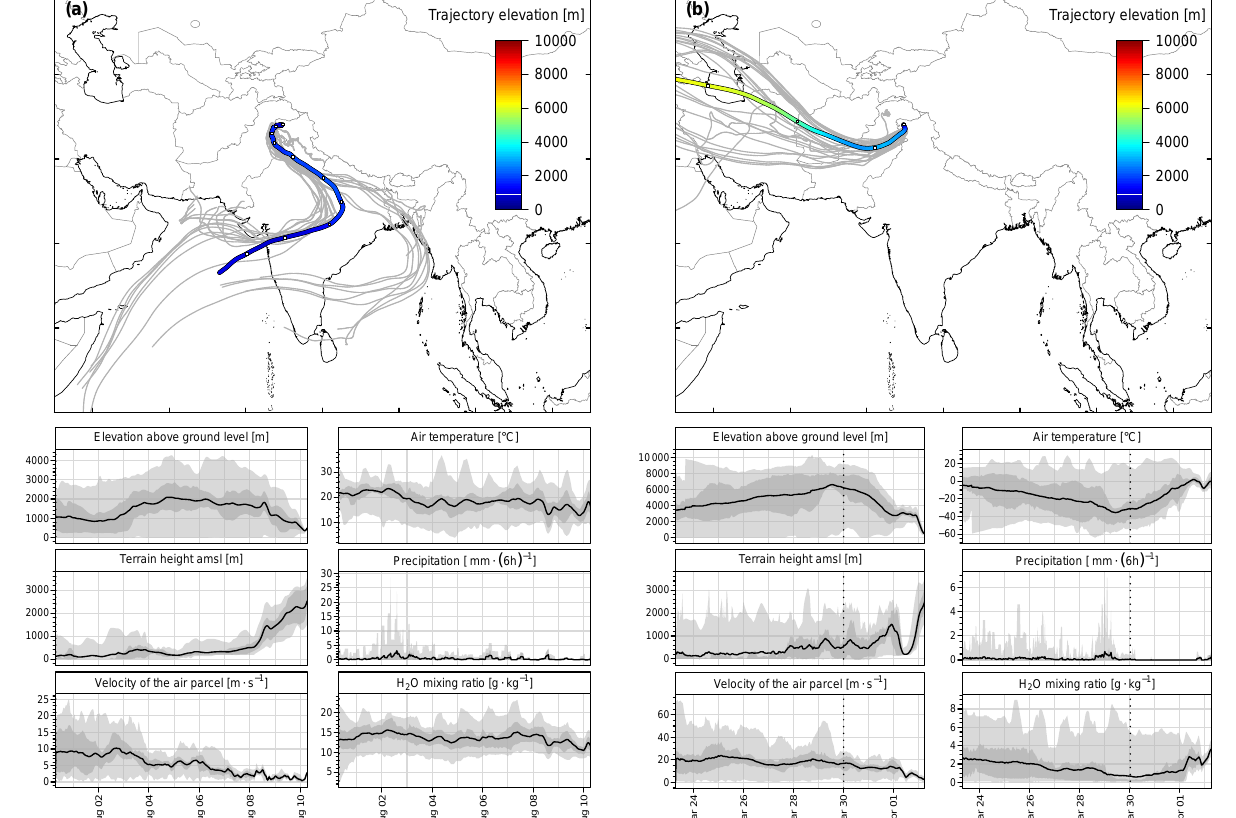
Figure 7. (a) Upper diagram: 10-day backward trajectories arriving at Srinagar station on 10 August 2010, 12:00LT and representing the Indian summer monsoon (ISM) period. (b) Upper diagram: 10-day backward trajectories arriving at Srinagar station on 2 April 2011, 12:00LT and representing the western disturbances (WD) period. Twenty seven ensembles (grey lines in the background) and the mean trajectory (heavy line) are shown. The colours of the mean trajectory indicate the elevation above ground level in metres. Empty white dots on the mean trajectory indicate 24hour intervals. The lower panels of (a) and (b) show the evolution of the six selected parameters of the air parcel along the trajectory. The evolution of the mean value of each parameter is marked by a heavy black line and the associated uncertainty in grey. Dashed vertical lines represent the part of the mean 10-day trajectory visible in the upper diagram. International boundaries are only indicative and as provided by the